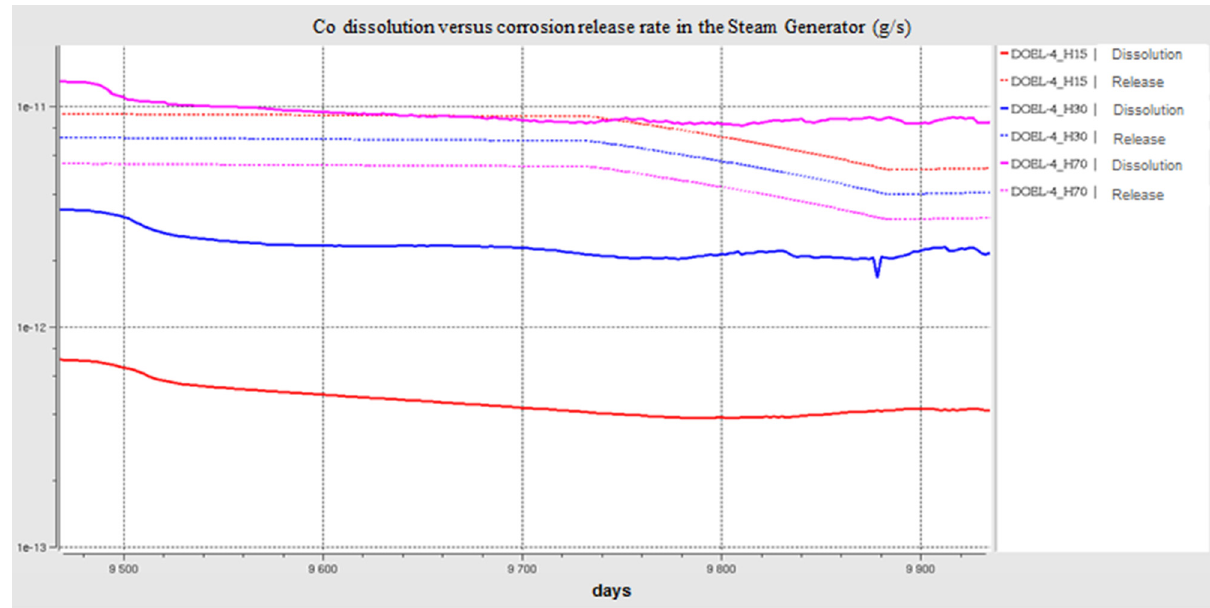
Fig. 12. OSCAR V1.3 calculation (cid:2) Co dissolution versus corrosion release rate in the steam generator region for cycle 25.